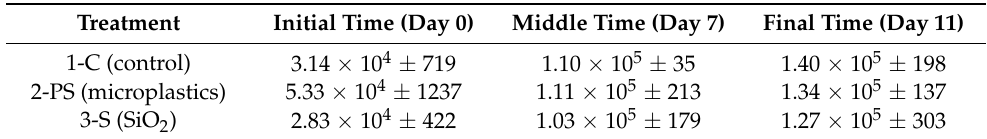
Figure 1. ( a ) Daily cell numbers from optical density (OD) measurements, per treatment. Each data point is the average of three replicate measurements per culturing flask ( ± standard deviation); ( b ) cumulative cell numbers per treatment. Table 1. Initial (day 0), middle (day 7) and final (day 11) cell numbers (number per mL) in the three treatments (1-C, 2-PS and 3-C) measured via optical density. Cell concentration on day 7 refers to the concentration measured prior filtration from each system, before experimental part